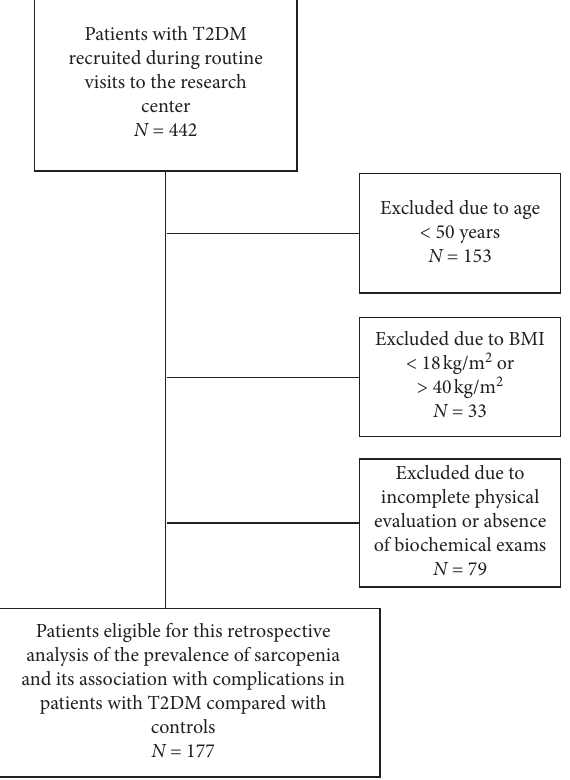
Figure 1: Study flow